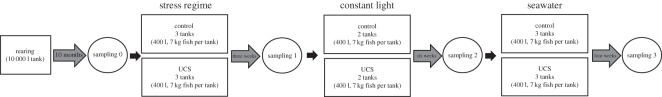
Schematic representation of the experimental protocol. UCS, unpredictable chronic stress.